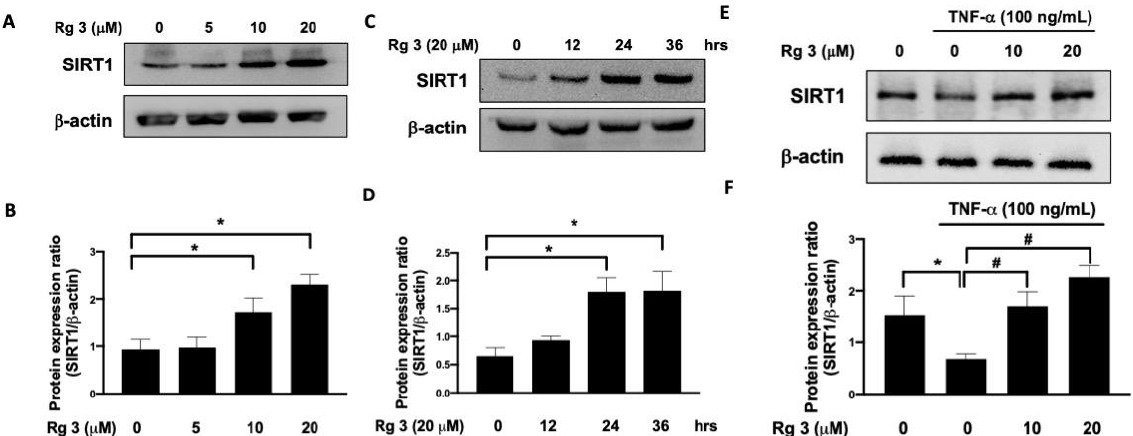
Figure 1. Rg3 enhances SIRT1 expression in chondrocytes. The expression levels of SIRT1 in C28a2 human chondrocytes treated with Rg3 were increased in dose-dependent ( A , B ) and time-dependent ( C , D ) manners. Representative Western blot images ( E ) and relative densitometric bar graphs of SIRT1/b-actin ( F ) in chondrocytes stimulated to 100 ng/mL TNF-a for 24 h were shown. (* indicating p < 0.05 compared with the control group; # indicating p < 0.05 compared to TNF- α -stimulated cells).